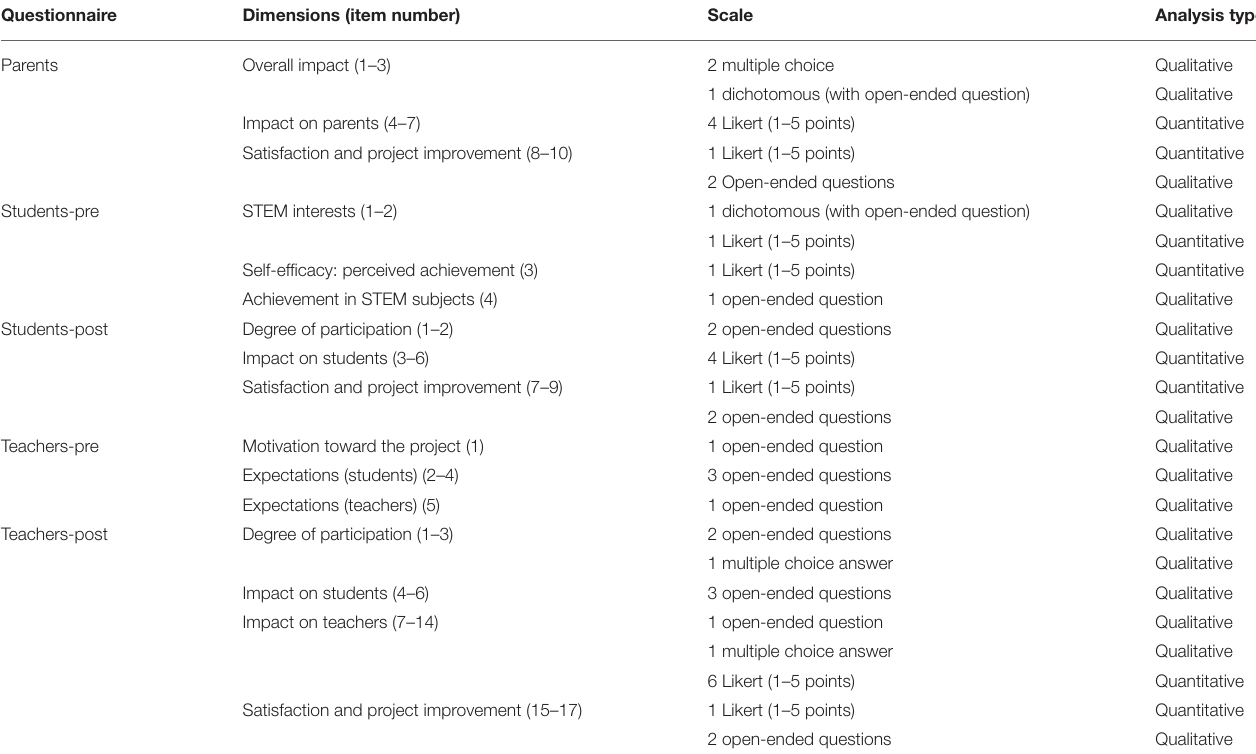
TABLE 9 | Design of the questionnaires